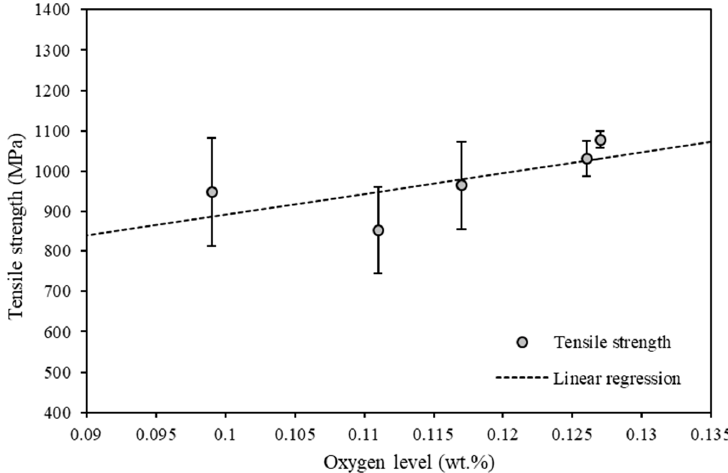
Figure 9. Tensile strength versus oxygen content within reused Ti6Al4V powder.